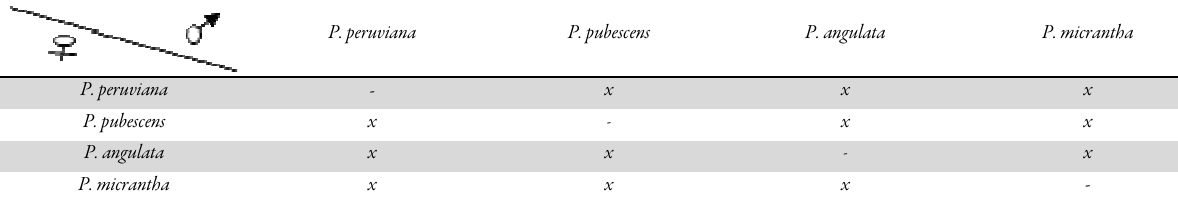
Table 3. The summary of the crosses in relation to the percentage of fertilized ovules and fruit set Crosses % Fertilized ovules